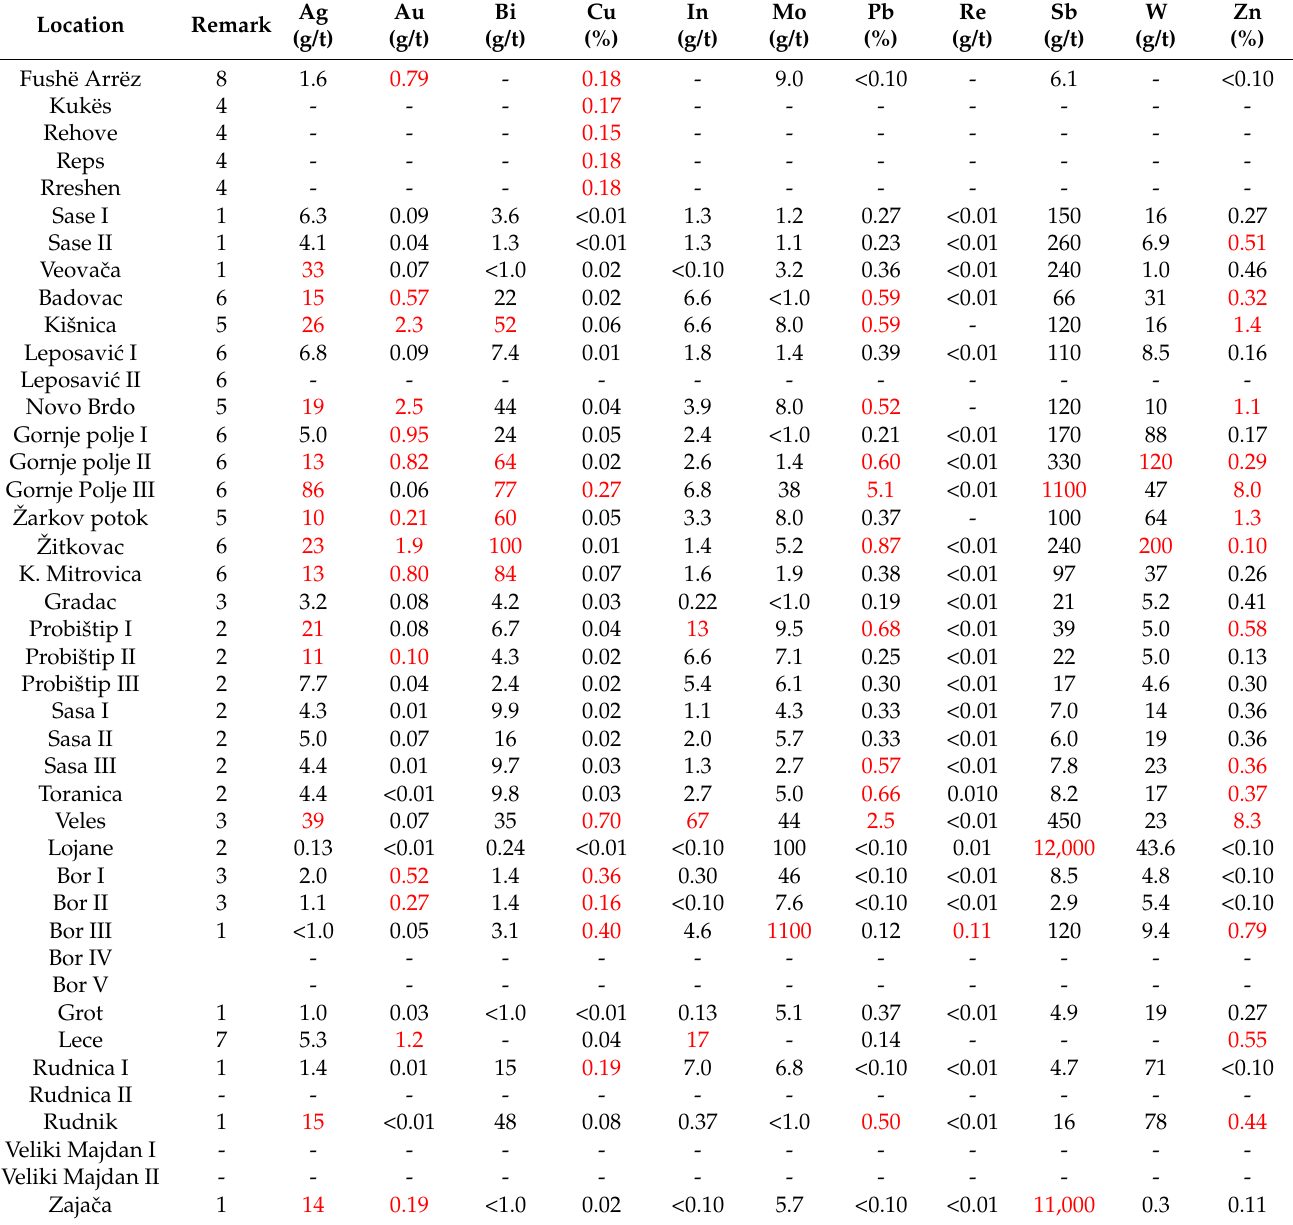
Table 2. Content of important chemical elements according to SRM